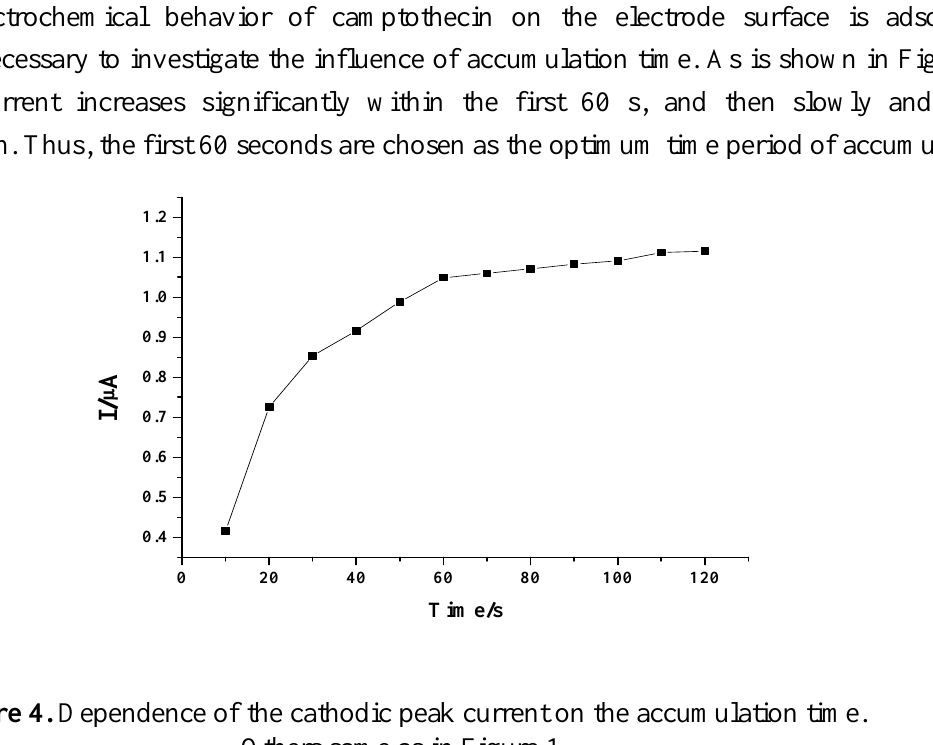
Figure 3. Plot of the cathodic (A) peak potential; (B) peak current against pH value. Others same as in Figure 1.